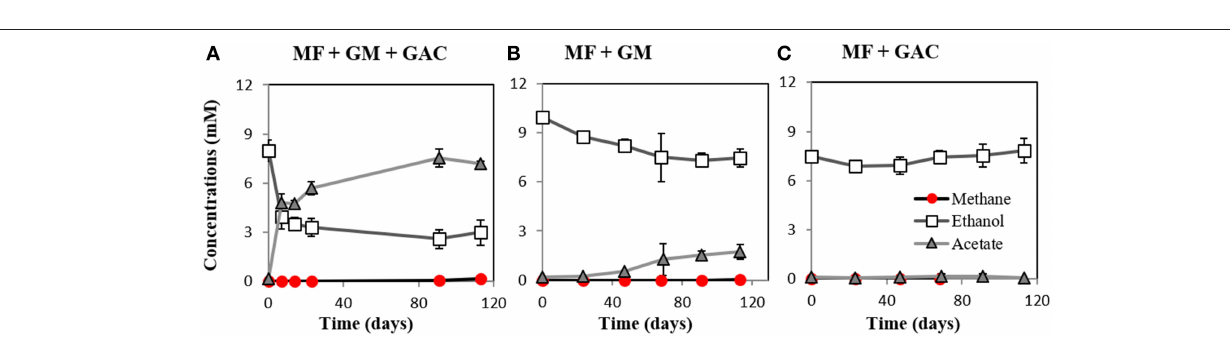
Frontiers in Energy Research |